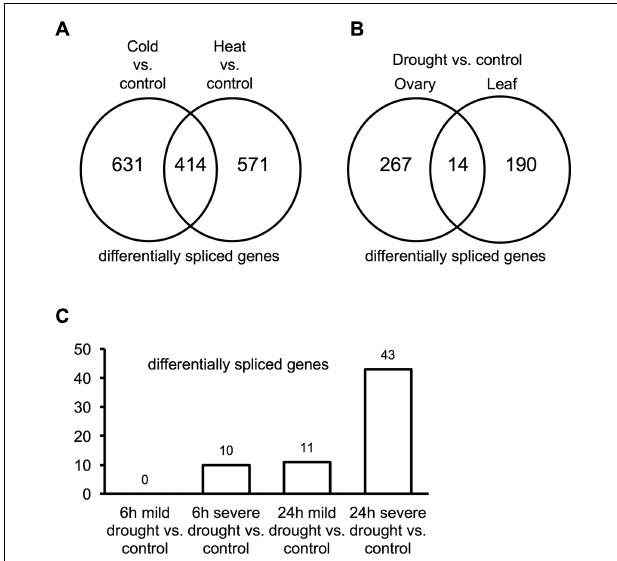
FIGURE 4 | AS associated with stress response. (A) Differentially spliced genes within seedlings induced in response to cold or heat treatment. (B) Differentially spliced genes within ovary vs. leaf induced in response to drought treatment. (C) Differences in the numbers of differentially spliced genes within root tissue subjected to mild vs. severe drought for short (6 h) vs. long (24 h)